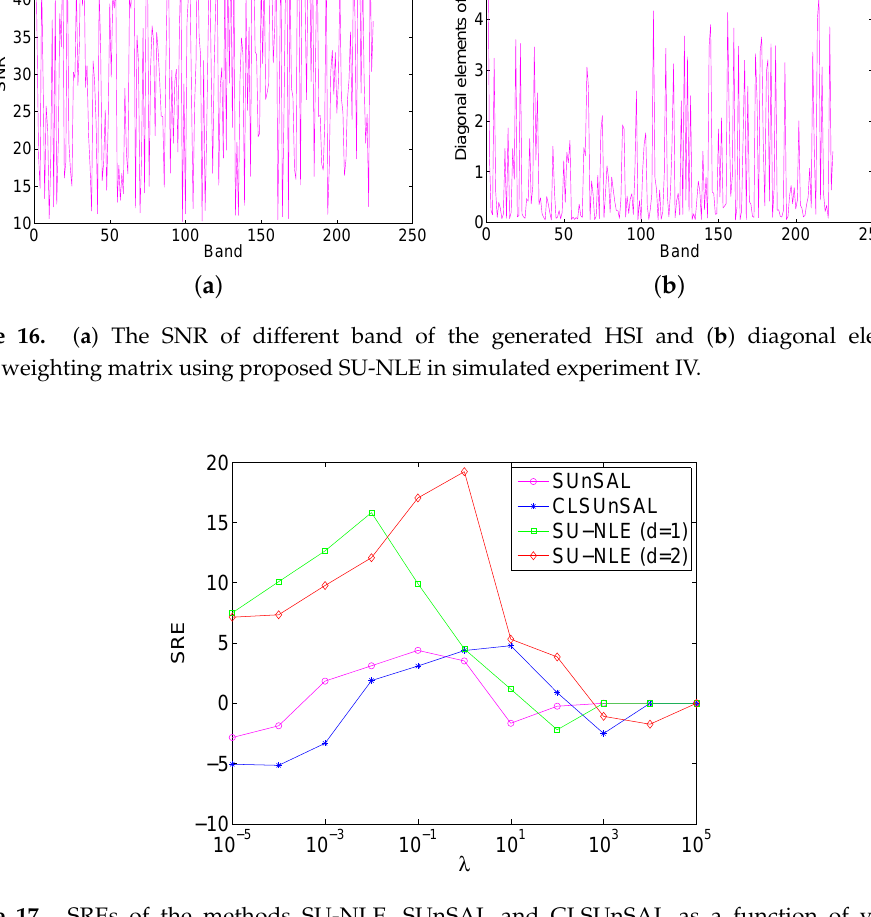
Figure 17. SREs of the methods SU-NLE, SUnSAL and CLSUnSAL as a function of varying regularization parameter λ under correlated noise with only mixed regions having 64 × 64 pixels and 224